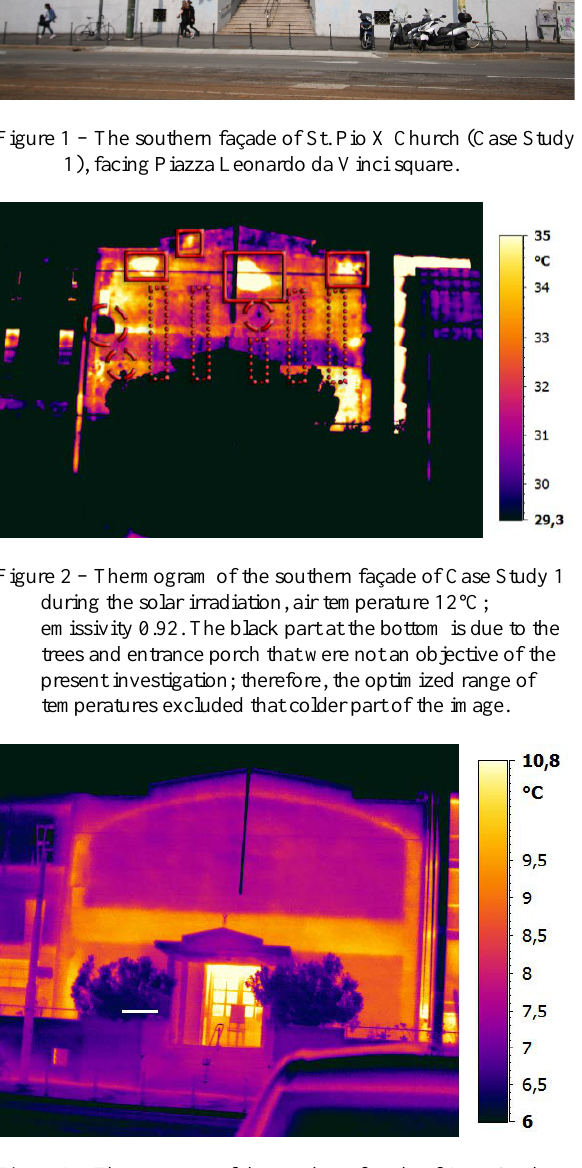
Figure 3 – Thermogram of the southern façade of Case Study 1, captured at dawn before the solar irradiation. The indoor air temperature was 18 C, outdoor 7 C, emissivity 0.92.